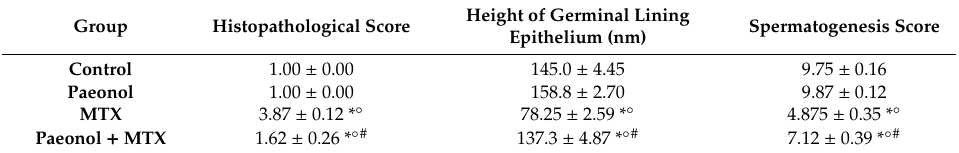
Table 2. E ff ect of paeonol on histopathological grades and spermatogenesis scoring.